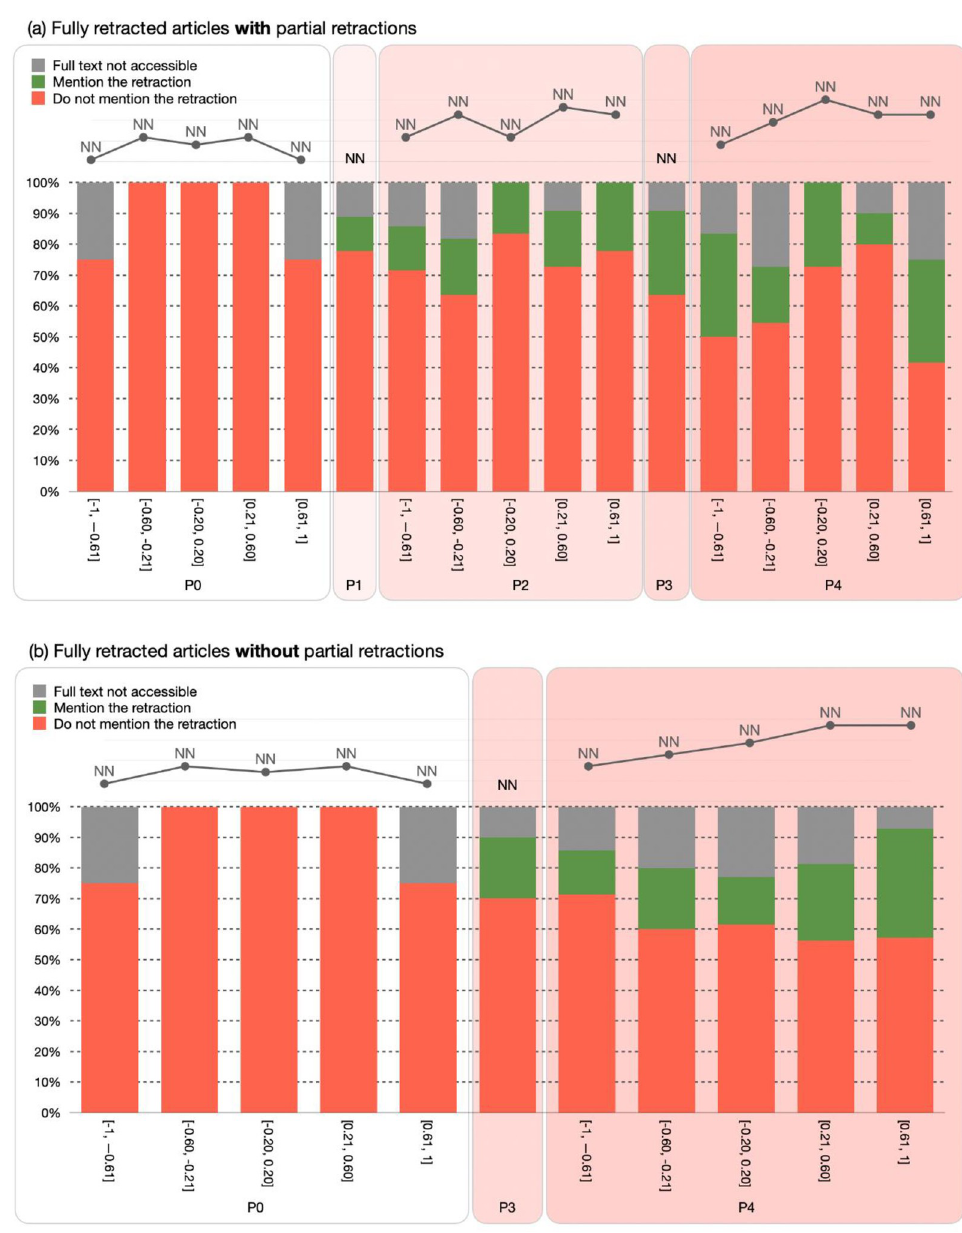
Fig 3. A graphical representation for the distribution of the citing entities in the PERIOD-SET. The graphic has two different versions sketched according to the retracted articles categories, i.e. RET-A (A) and RET-B (B). It also highlights the citing entities that have/have not mentioned the retraction, along with the citing entities that do not have an accessible full text. Fig 5 shows how to represent D1. The visualization is based on a grouped bar chart and the number of in-text citations as a function of the P and P of the related citing entities for X CUT which we can access their full text. As for the citing entities, the visualization has two versions based on the retracted articles category. In case the RET-SET contains retracted articles of type RET-A and RET-B, then each type is treated separately and has its version. The in-text cita- tions are classified under the three citation sentiments: negative , neutral , and positive , indicated